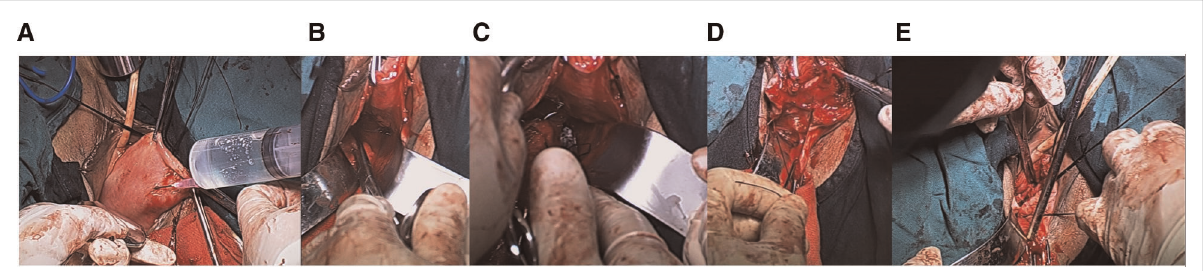
FIGURE 1 Intraoperative illustration of patients in the control group. ( A ) The vaginal wall is incised, and the gap is separated to the sciatic spinous ligament; ( B ) the space around the sacrospinous ligament is separated to expose the sacrospinous ligament; ( C ) the sacrospinous ligament is sutured about 2 cm inside the sacrospinous ligament; ( D ) the other end is sutured on the fascia of the posterior vaginal wall and does not penetrate the posterior vaginal wall; ( E ) the vaginal fornix is raised after knotting the